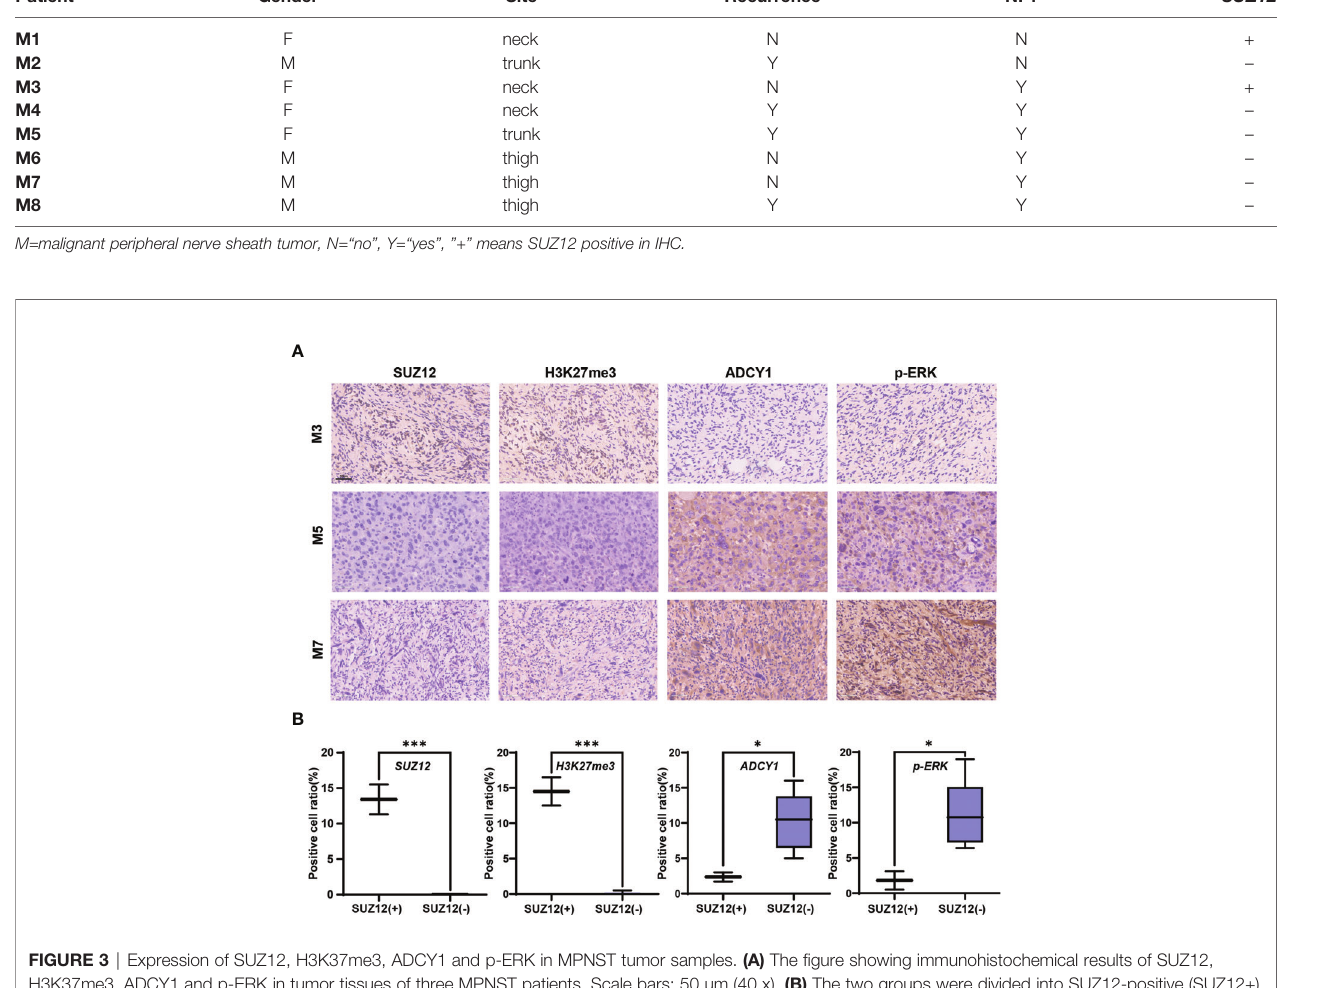
TABLE 1 | Clinical information and SUZ12 expression in 8 patients with MPNST. Patient